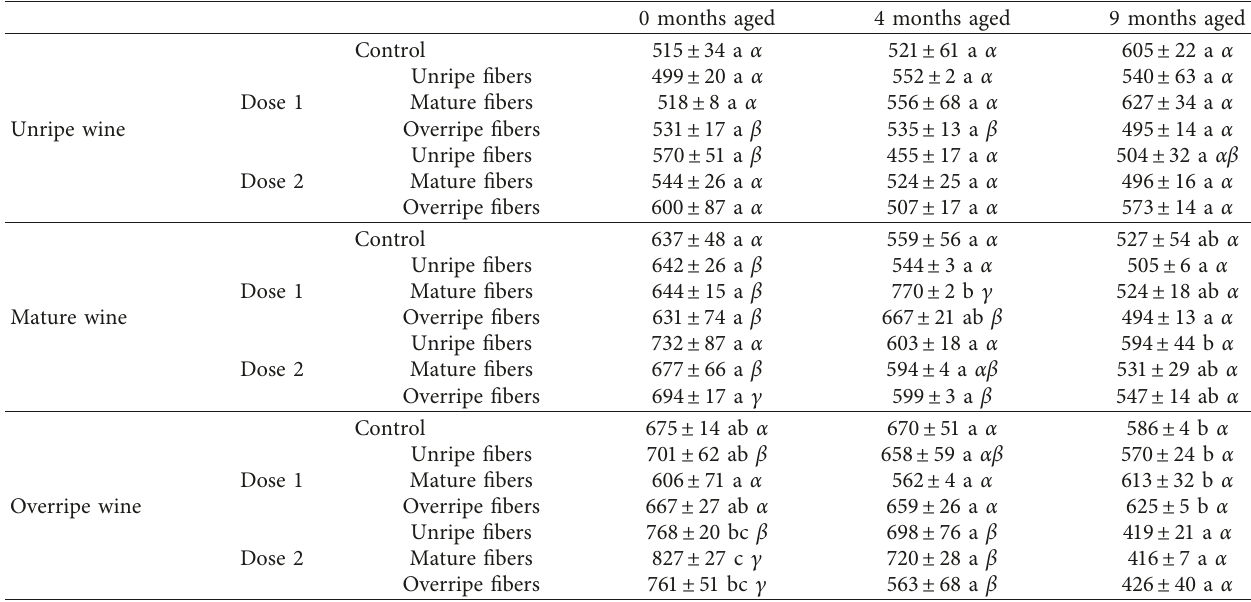
Table 9: Proanthocyanidin content of the wines expressed as